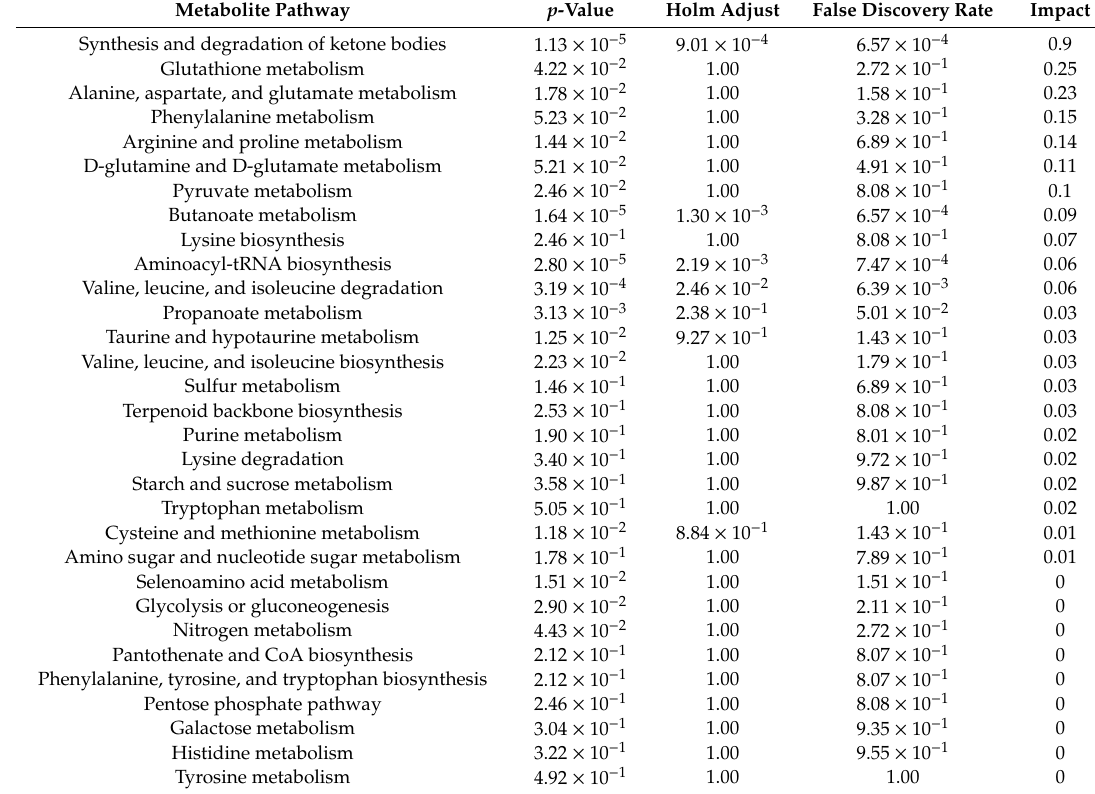
Table 5. Potential metabolite pathway analysis by using MetaboAnalyst